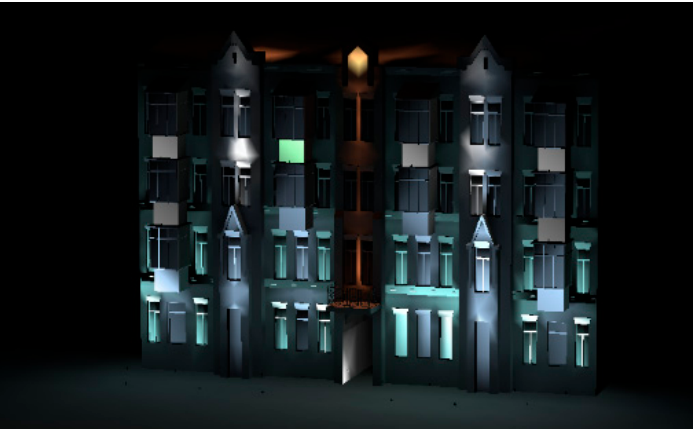
Designs 2021 , 5 , x FOR PEER REVIEW 24 of